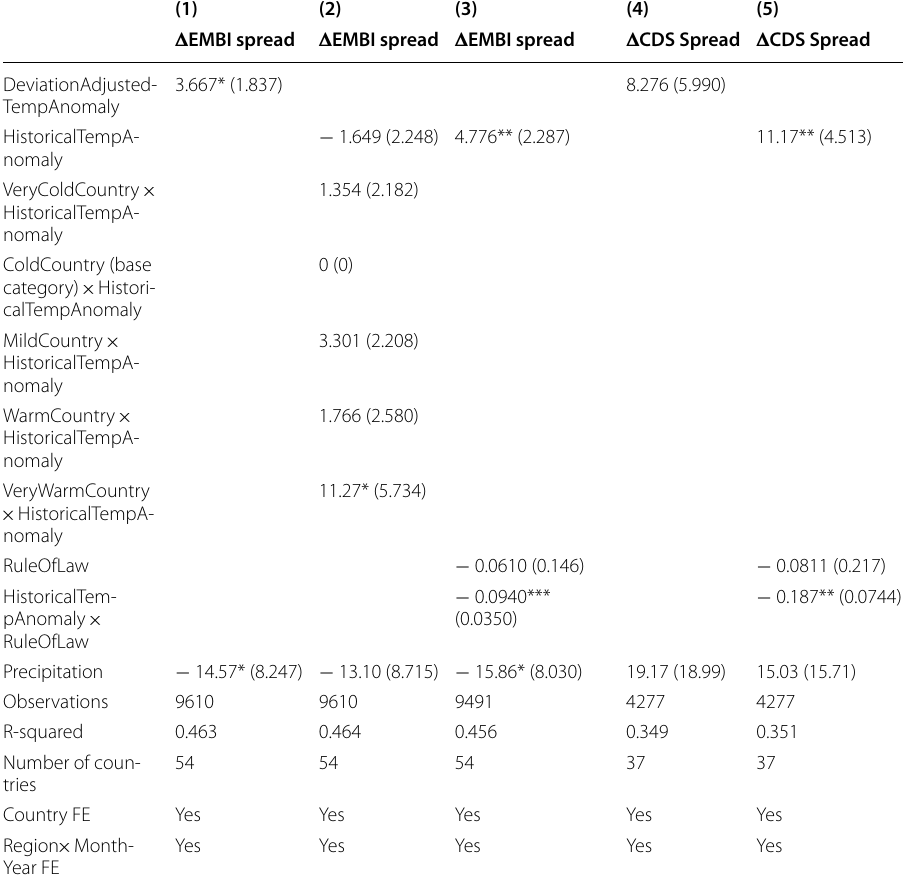
Table 13 Robustness tests: changing dependent